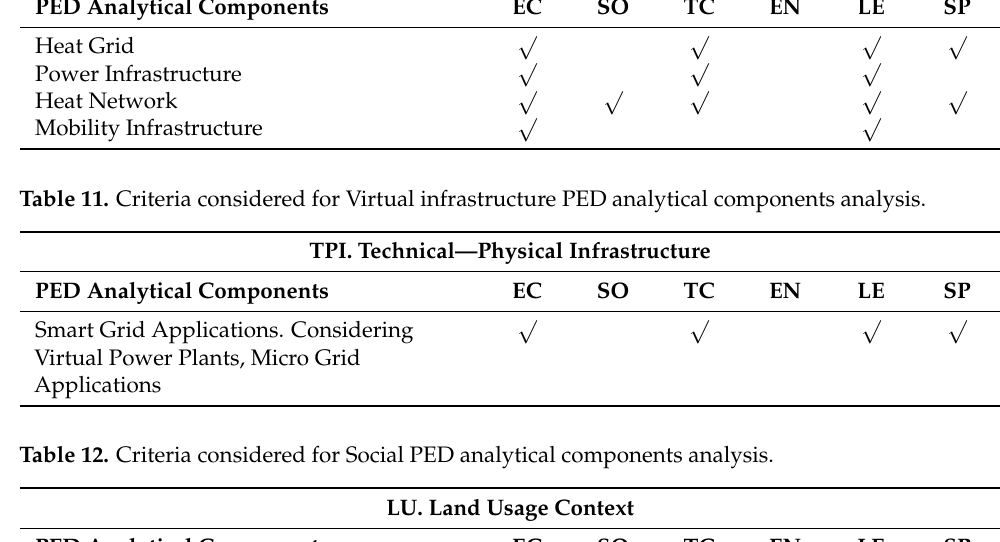
Table 10. Criteria considered for Technical–physical infrastructure PED analytical components analysis. TPI. Technical—Physical Infrastructure